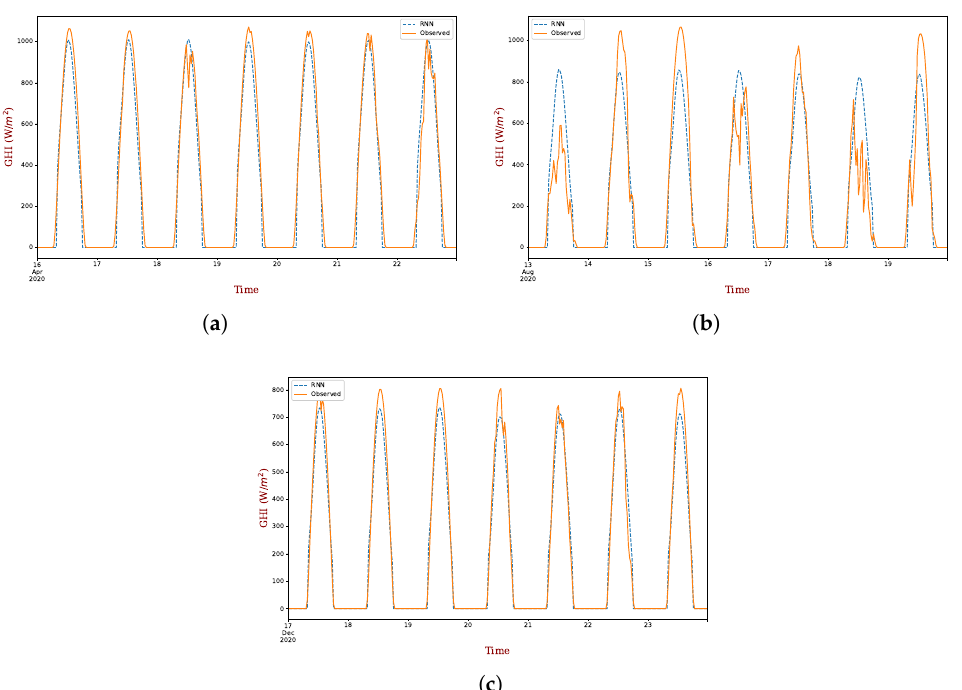
Figure 12. GHI prediction for three weeks of 2020 with RNN. ( a ) Week 16. ( b ) Week 33. ( c ) Week 51.